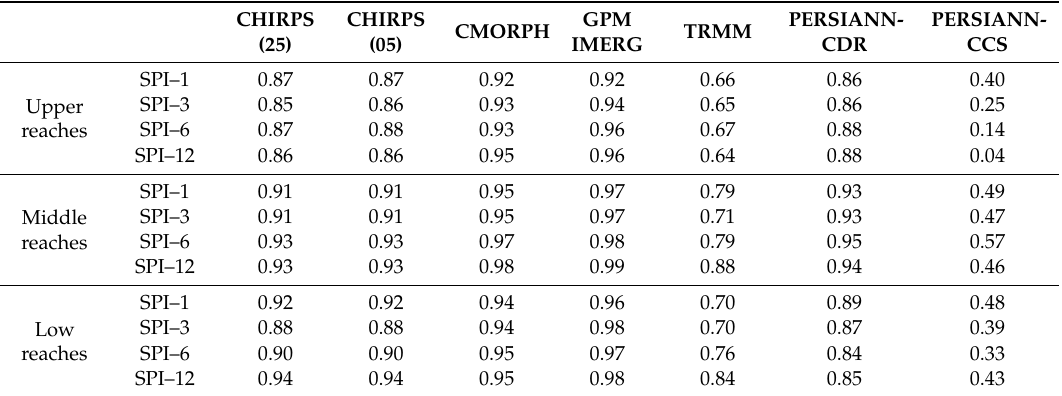
Table 6. R values between SPI–1, SPI–3, SPI–6, and SPI–12 results obtained from SPPs and observations for upper, middle, and lower